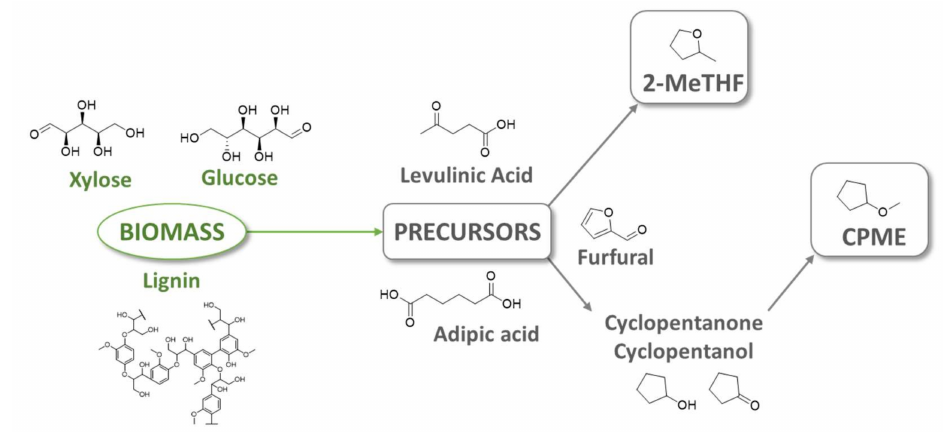
Figure 1. Biogenic pathways options for the synthesis of bio-based CPME and